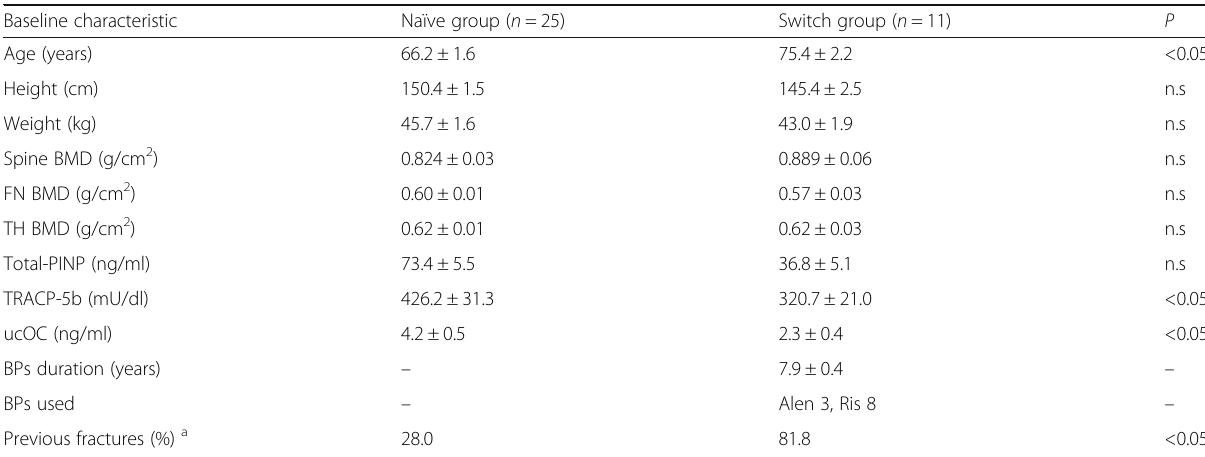
Table 1 Baseline characteristics Baseline